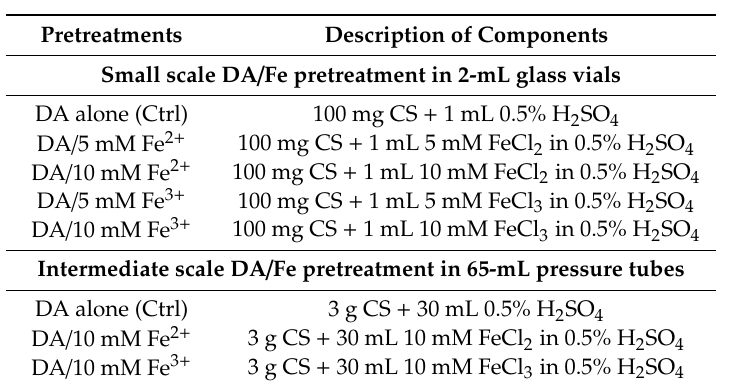
Table 3. Pretreatment conditions specifying the quantity of biomass, iron co-catalyst and solvent for dilute acid pretreatments. Five replicates were conducted for each of the treatments. Abbreviation: ddH 2 O, deionized distilled